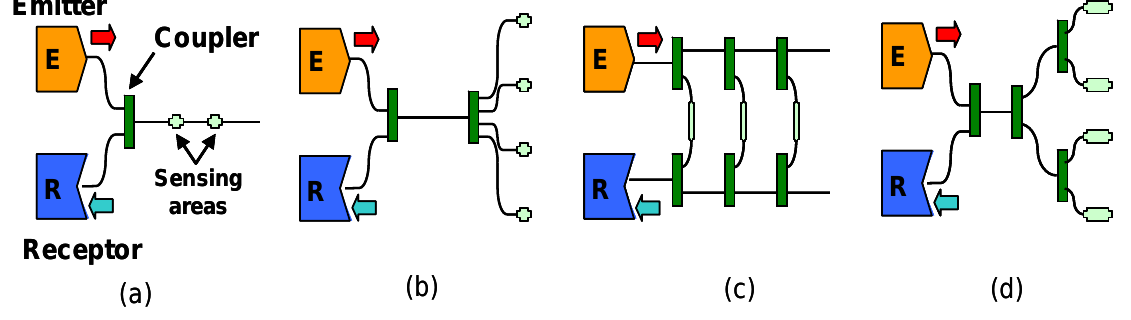
Figure 2. Examples of optical fiber sensor networks: (a) line, (b) star, (c) ladder, (d)